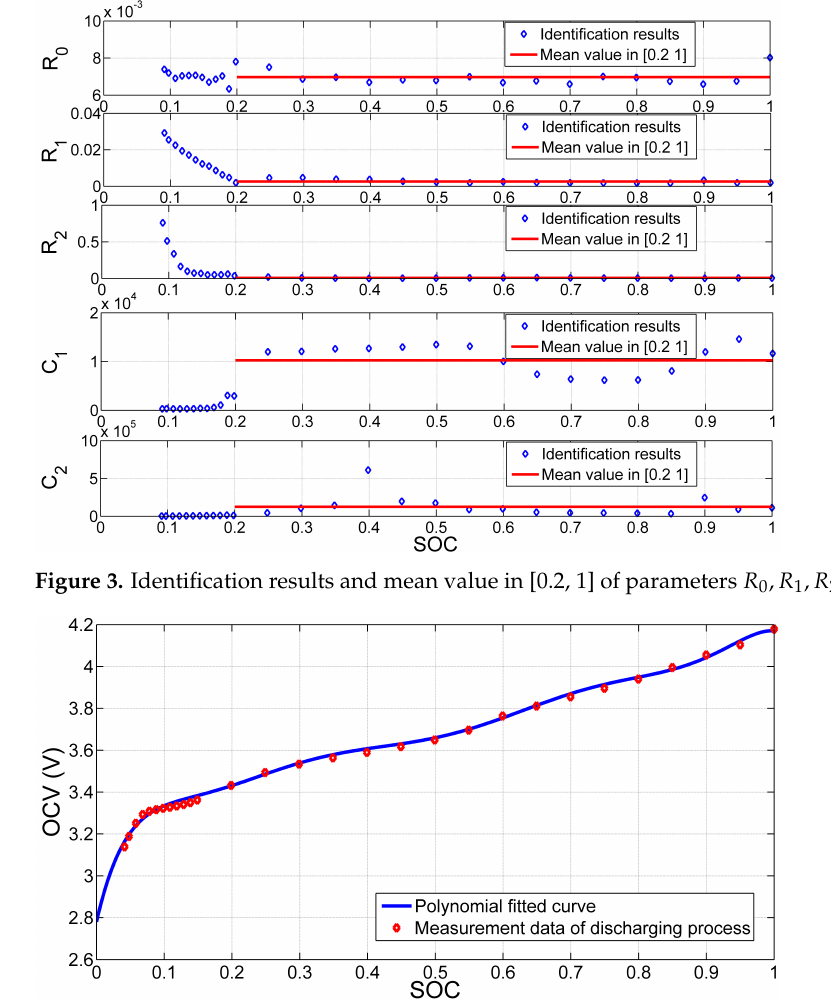
Figure 4. Measurement data and fitted curve of OCV vs.